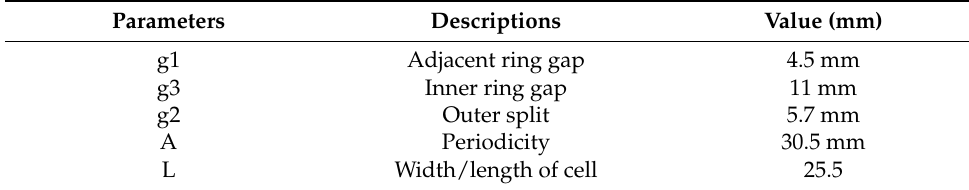
Table 3. Optimized parameter values for the array SRR